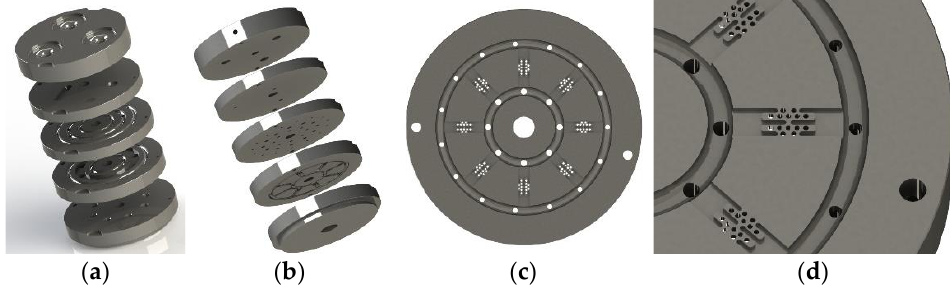
Figure 2. The 3D models of the spinning pack for the fiber with a “fishbone” cross-section. ( a ) Top view of spinning pack assembly; ( b ) bottom view of spinning pack assembly; ( c ) distribution board; ( d ) partial view of distribution plate.